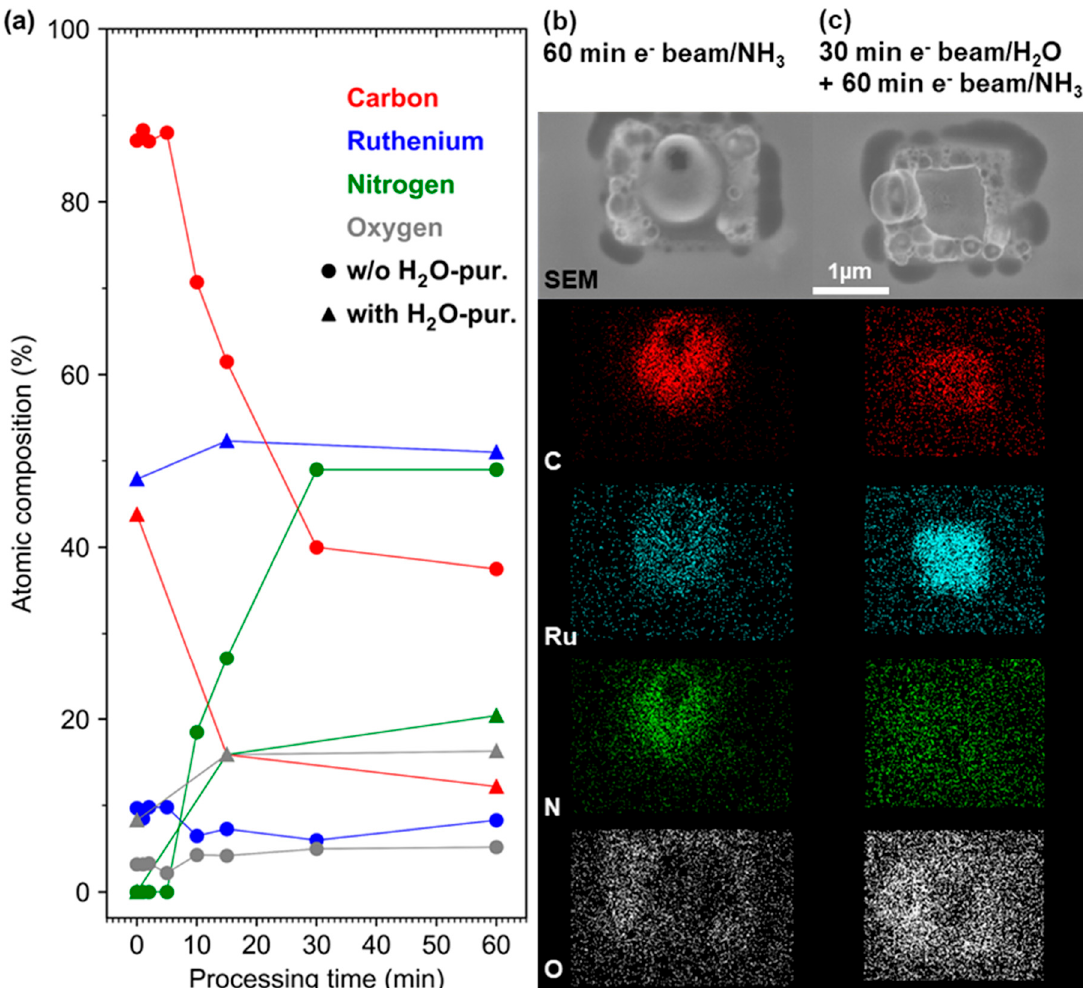
Figure 2. Results of NH 3 -assisted processing experiments in an environmental scanning